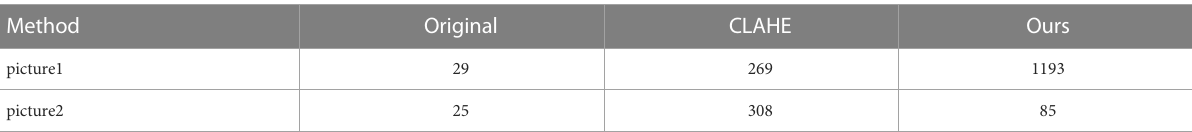
TABLE 12 The results of keypoint matching.